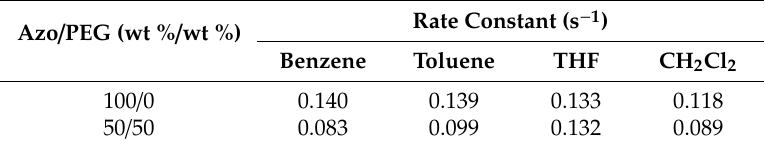
Figure 3. Variations in the UV–Vis spectra of ( a ) neat Azo and ( b ) 50:50 Azo/PEG complex dissolved in benzene during UV irradiation. The complex compositions are designated in wt %. Table 1. Rate constants of trans-to-cis photoisomerization for neat Azo and for its complex in combination with PEG in various solvents obtained through the UV–Vis